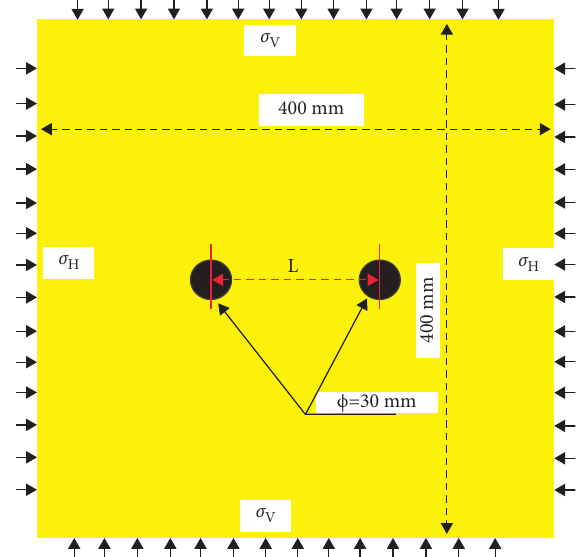
Figure 1: Double-hole model for hydraulic fracturing. Table 1: The input parameters of the